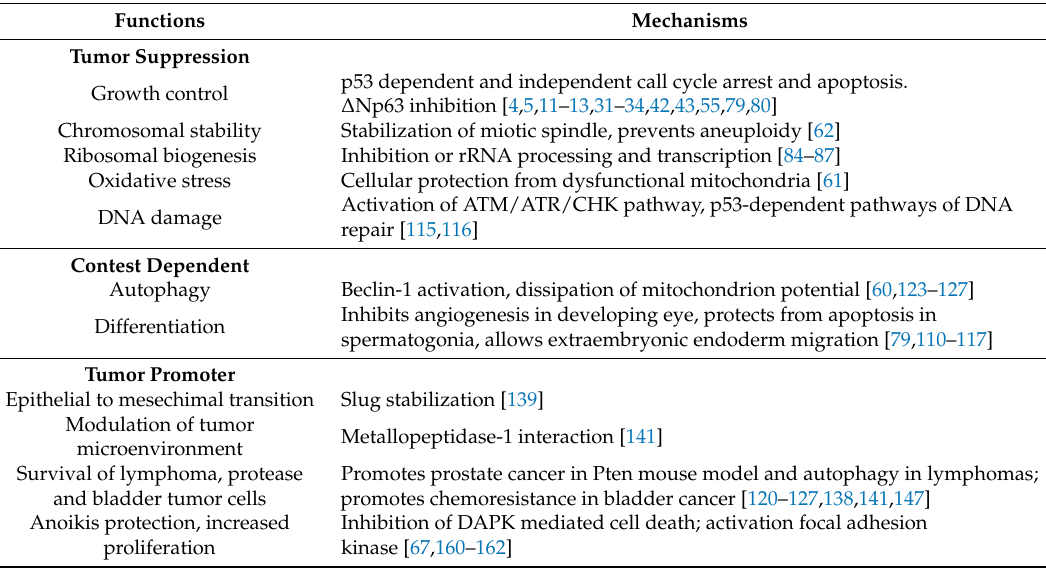
Table 1. ARF roles in cell proliferation and molecular mechanisms of the observed